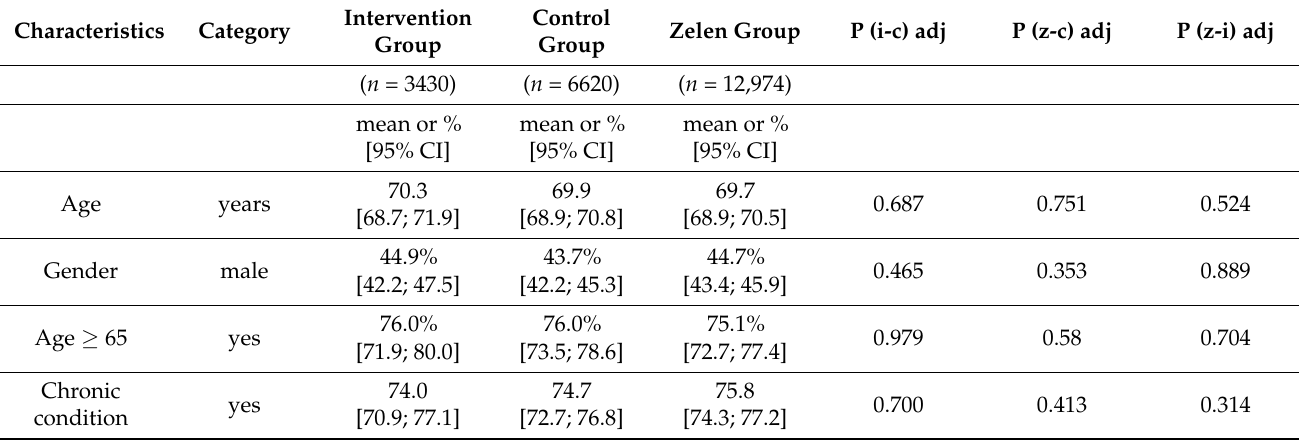
Table 1. Baseline